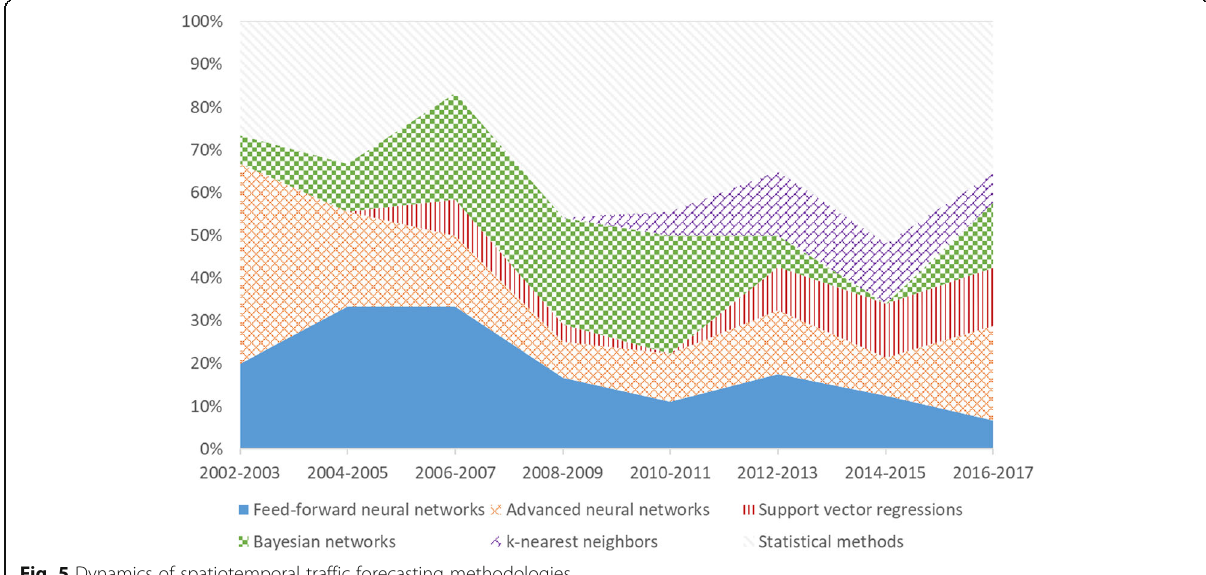
Fig. 5 Dynamics of spatiotemporal traffic forecasting